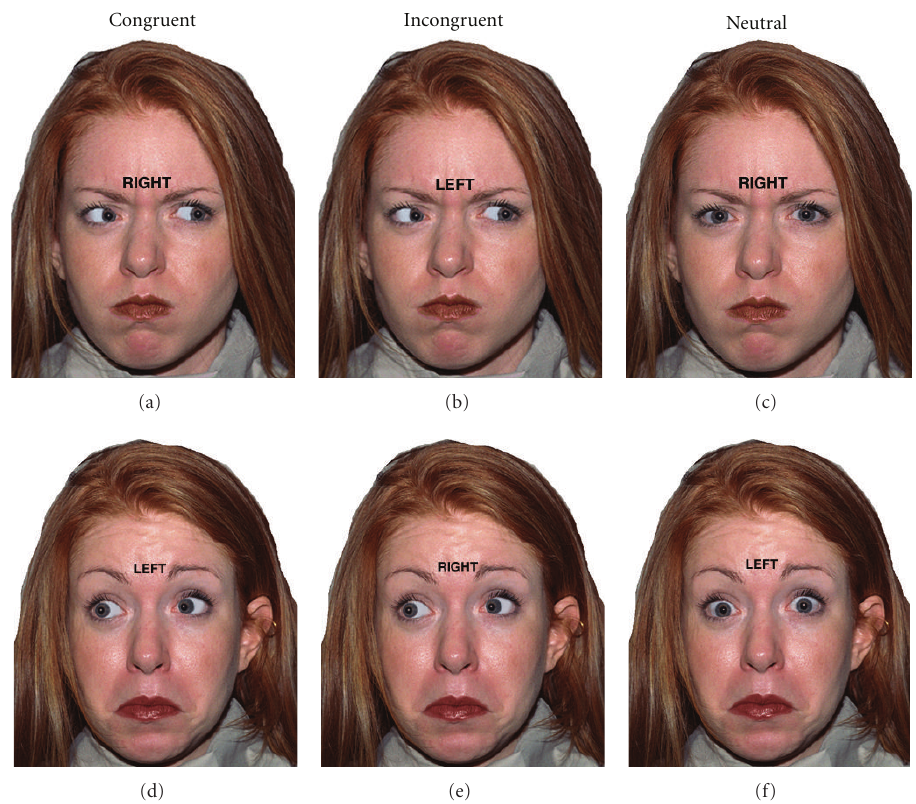
Figure 1: Examples of stimuli. The three columns illustrate the three conditions , congruent, incongruent, and neutral, formed by the direction indicated by the target word relative to that of eye-gaze. Top row shows faces with angry expressions and bottom row shows faces with fearful